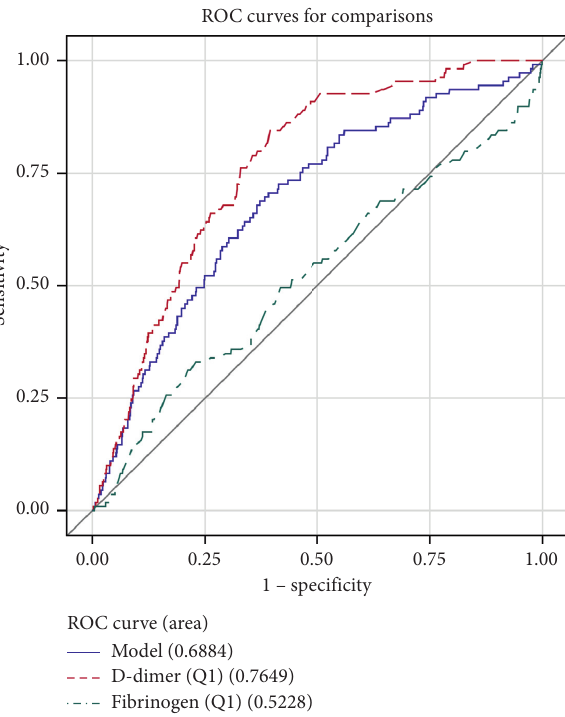
Figure 2: ROC curve for comparisons of D-dimer, fibrinogen, and combination of them in patients (age ≤ 45).